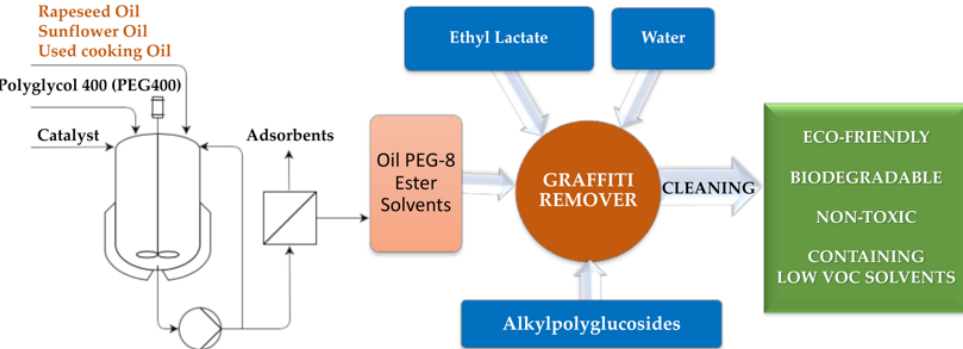
Figure 1. General approach of the performed studies. Oil PEG-8 ester solvents denote the following esterified oils (for the abbreviation see Table 1): MG-400-RO (derived from rapeseed oil), MG-400-SO (derived from sunflower oil), MG-400-UCO (derived from used cooking oil).